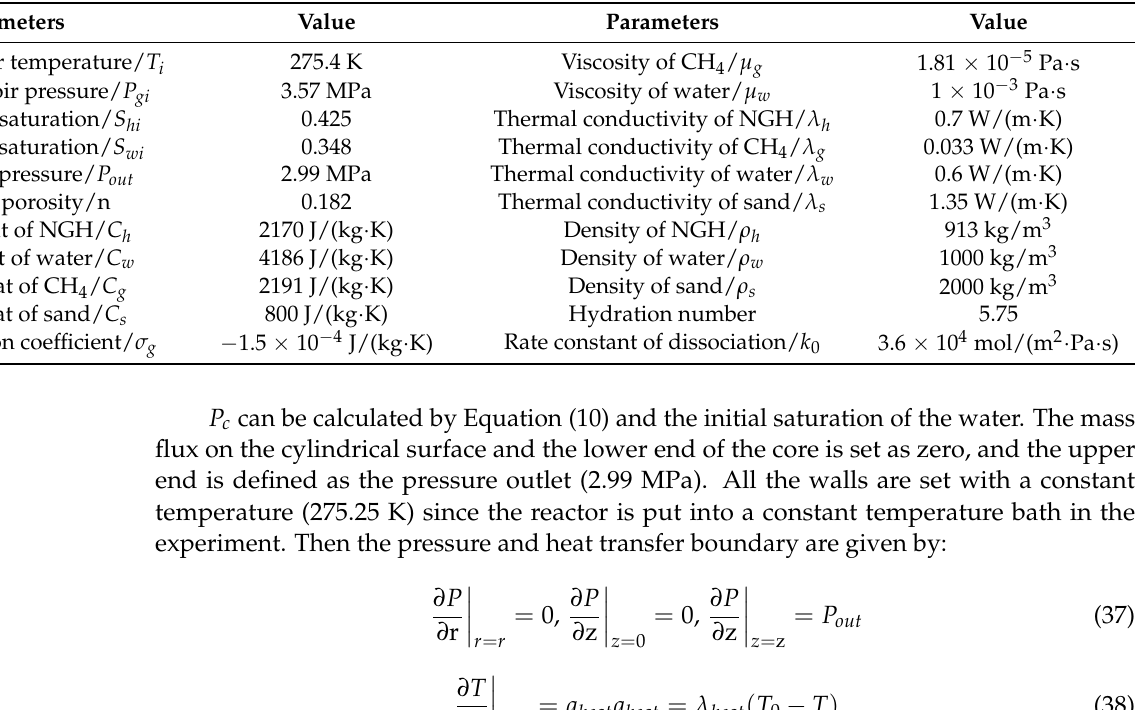
Table 1. Parameters adopted in this study